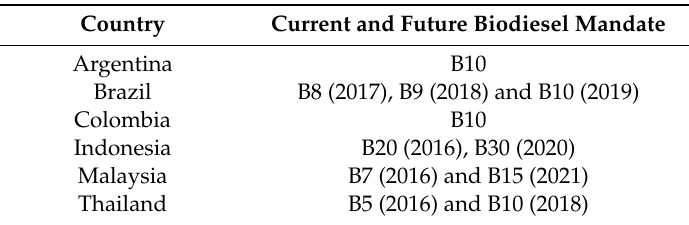
Table 5. Current biodiesel mandates in various countries [41].